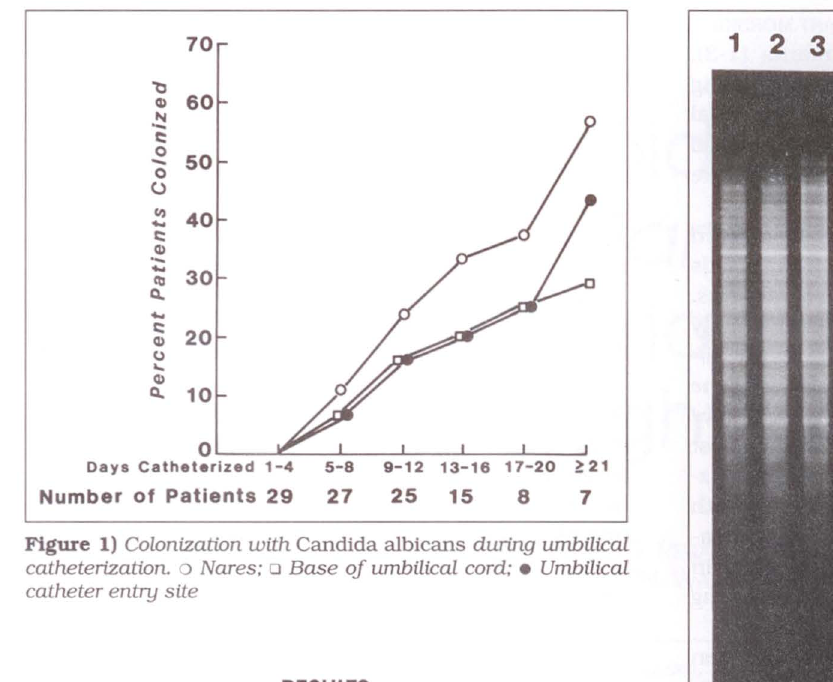
Figure 1) Colonization with Candida albicans during umbilicaL catheterization. o Nares; o Base of umbilicaL cord; • UmbilicaL